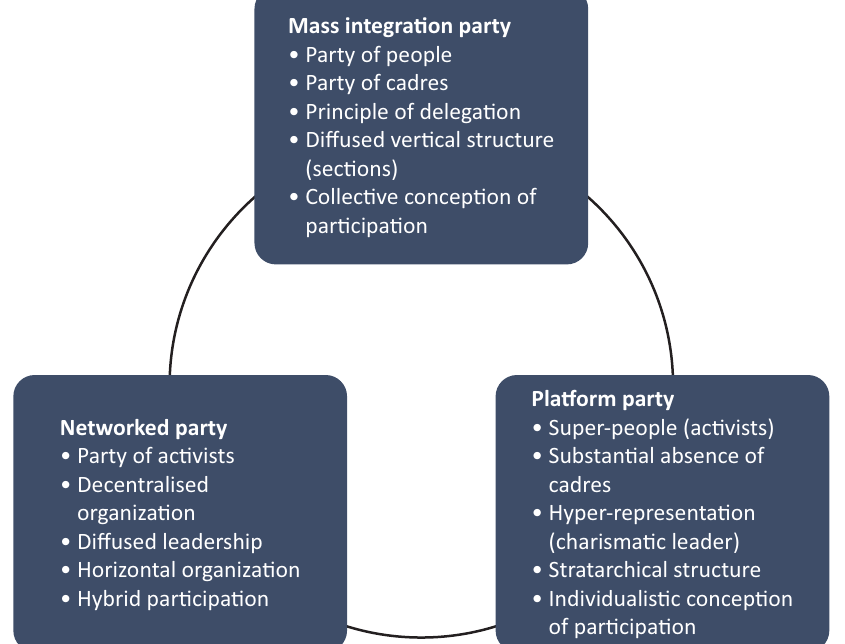
Figure 1. Characteristics of the mass party, platform party, and networked